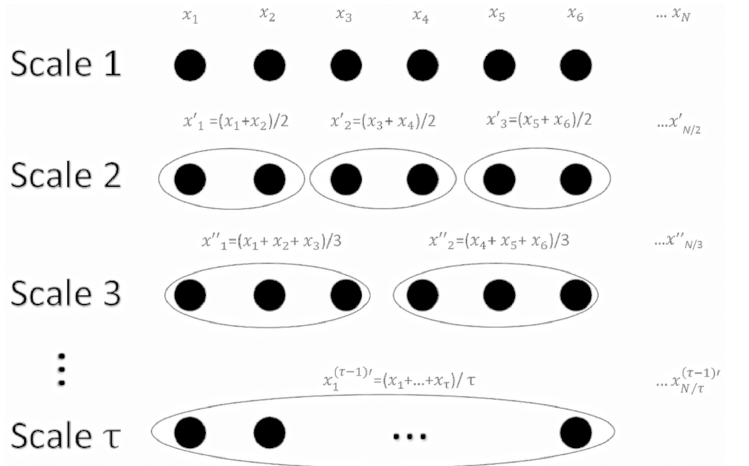
Fig 1. The illustration of the coarse graining procedure for scales 1 to τ